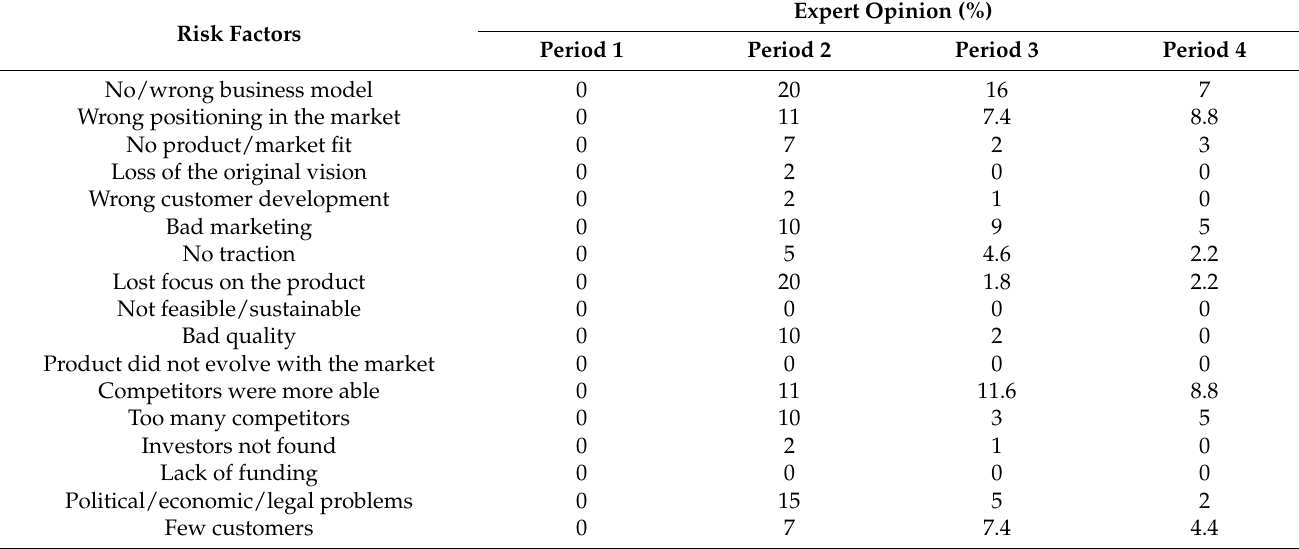
Table A3. The expert’s opinion about start-up